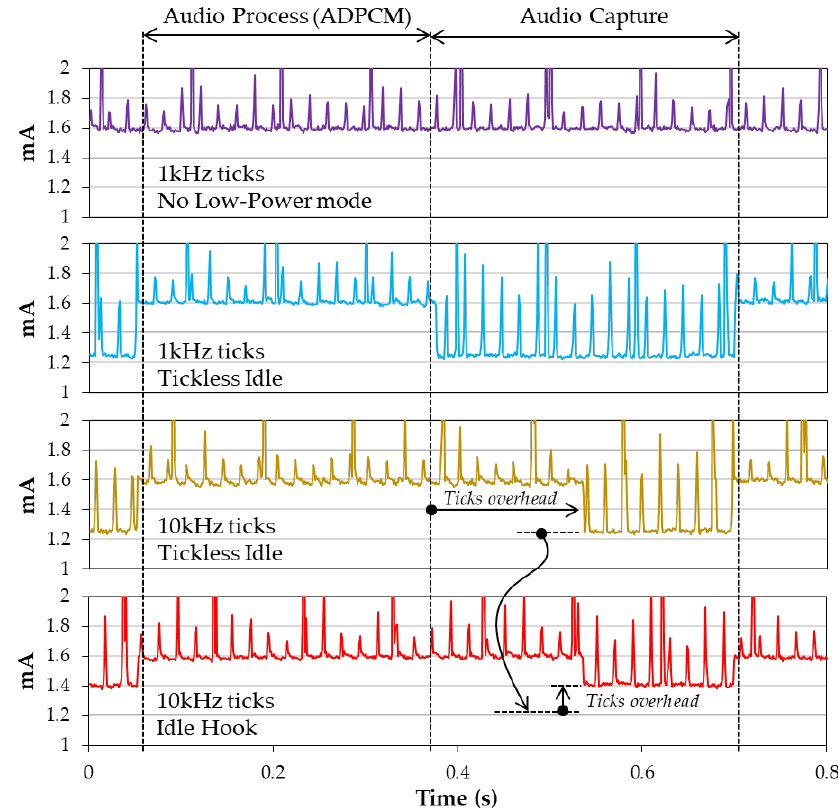
Figure 12. RTOS low-power